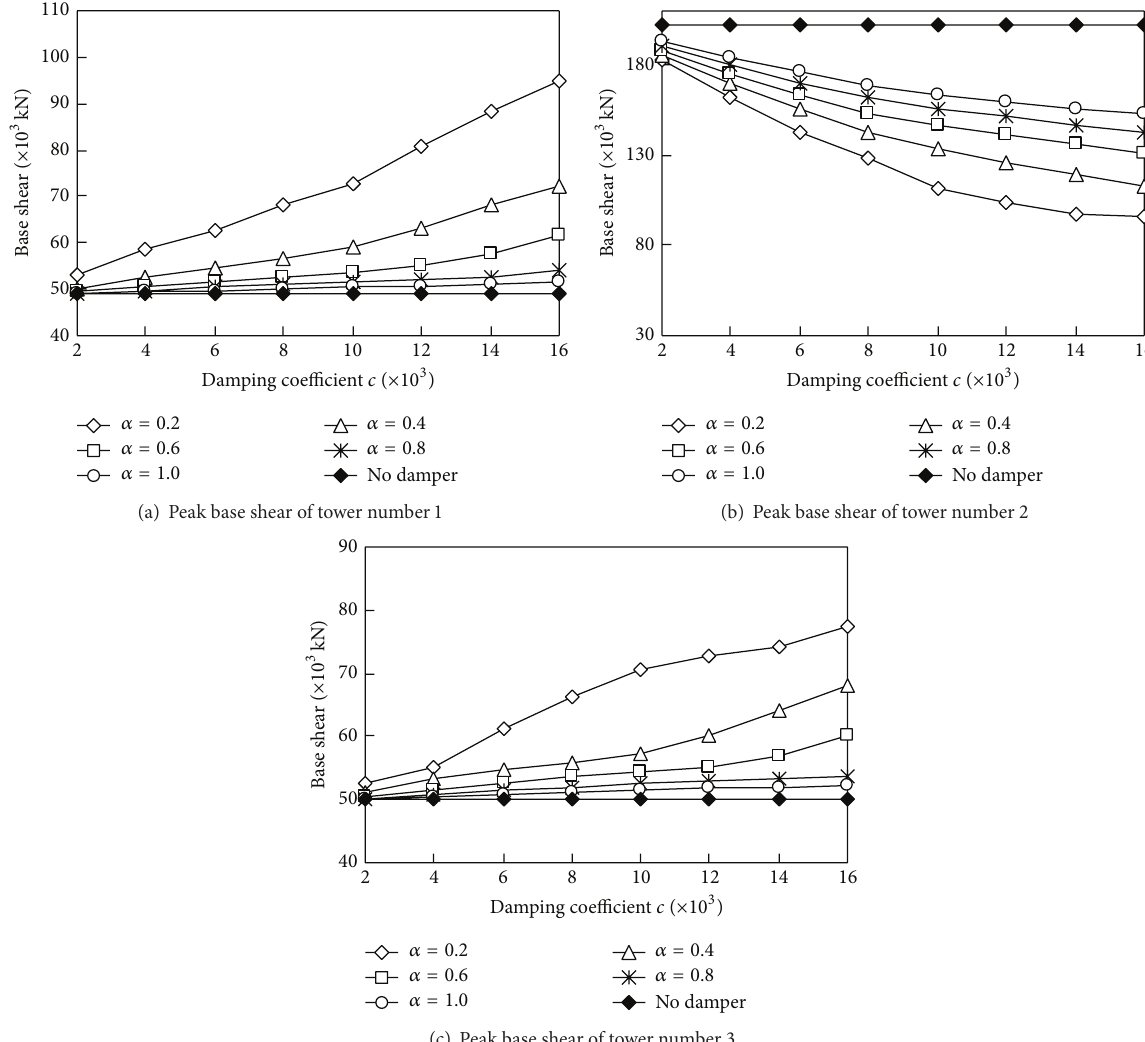
Figure 7: Effects of variations in damping coefficient and velocity exponent of the viscous fluid dampers on the peak base shears of bridge